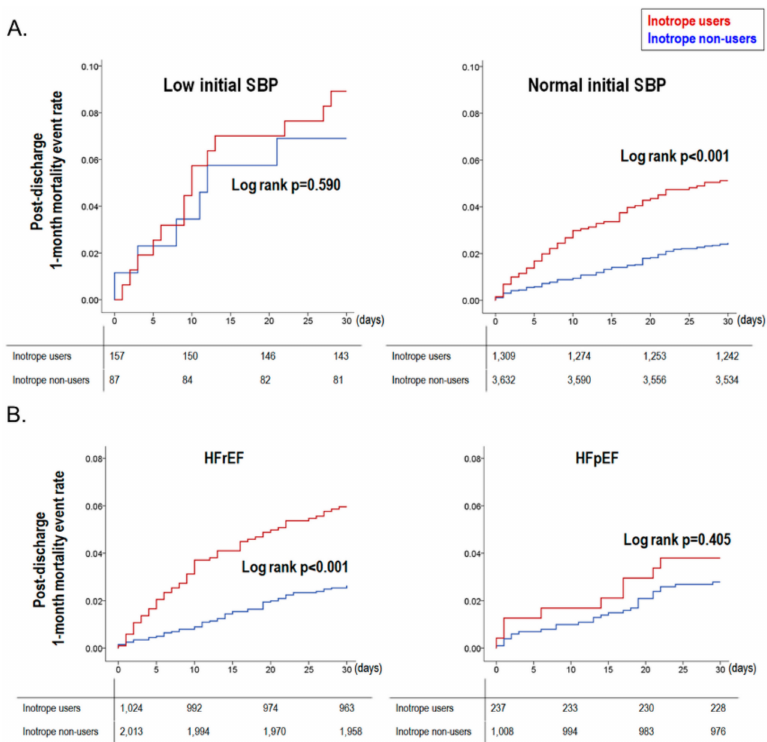
Figure 3. Post-discharge 1-month mortality events by inotrope use in subgroup